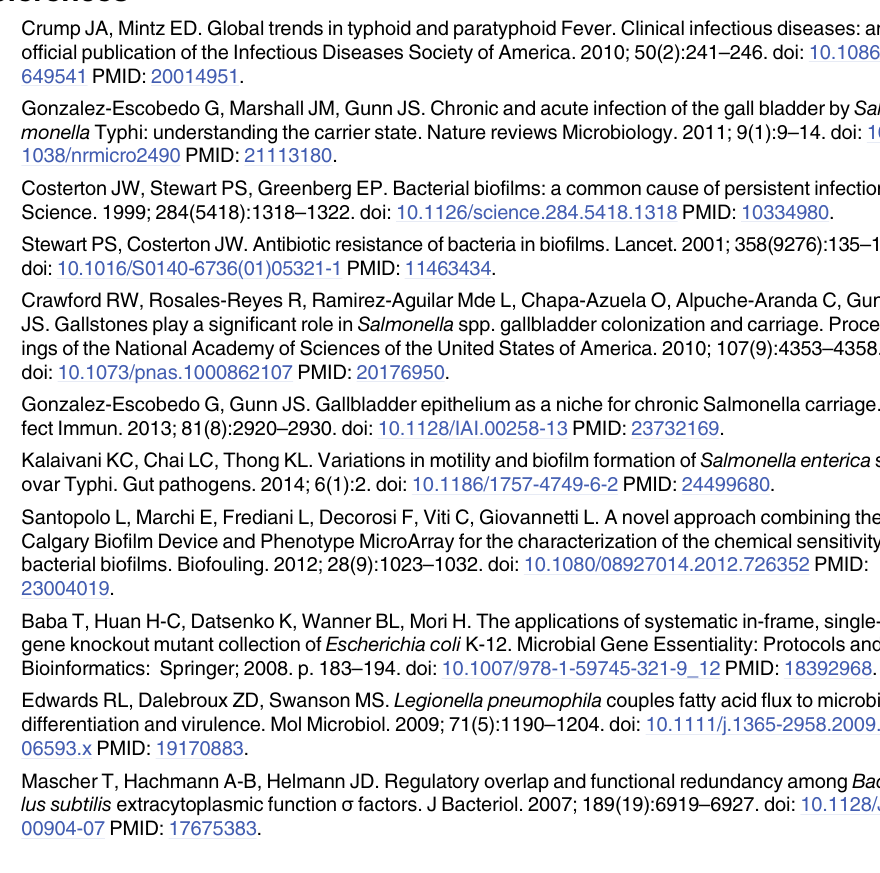
S3 Table. Raw Phenotype MicroArray data and presence/ absence of catabolism- related genes in the S . Typhi human carrier strain CR0044. S4 Table. Selected carbon substrates utilized by Salmonella Typhi strains in 3 different bac- terial growth stages; planktonic, biofilm and inducing transition of planktonic cells to form biofilm.